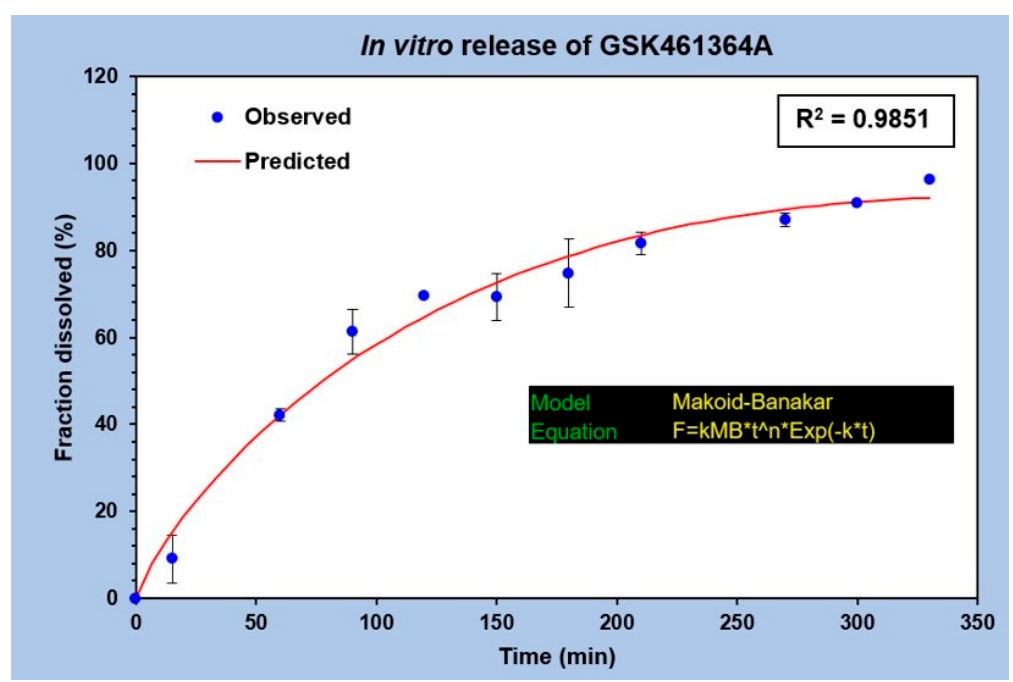
Figure 4. In vitro release profile of GSK461364A from PLGA-PEG nanoparticles performed in 1X PBS, pH 7.4 at 37 °C (n = 3).